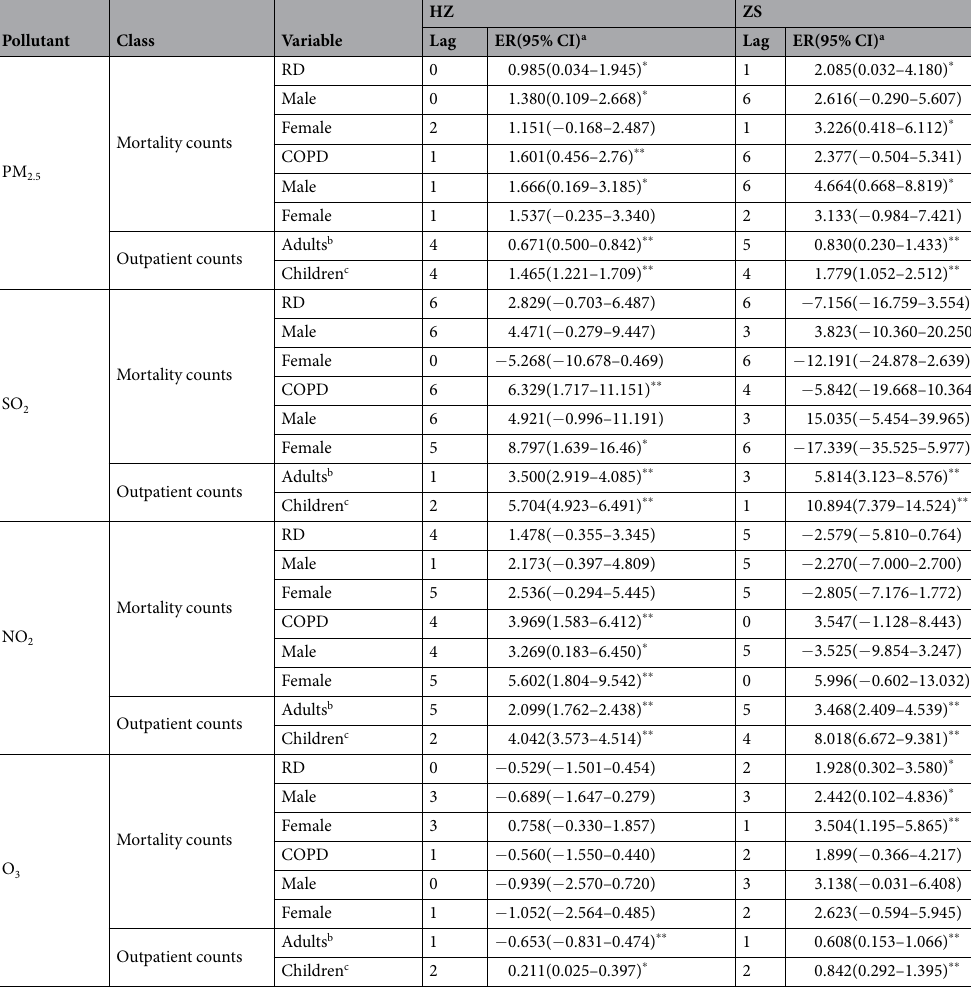
Table 4. Excess Risk of respiratory mortalities and outpatients per 10 μ g/m 3 increase of air pollutants in